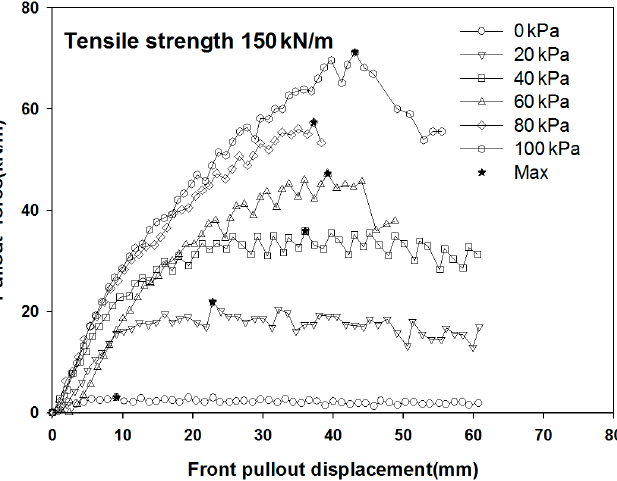
Figure 7. Front pullout displacement versus pullout force with confining stress (T g = 150 kN/m).